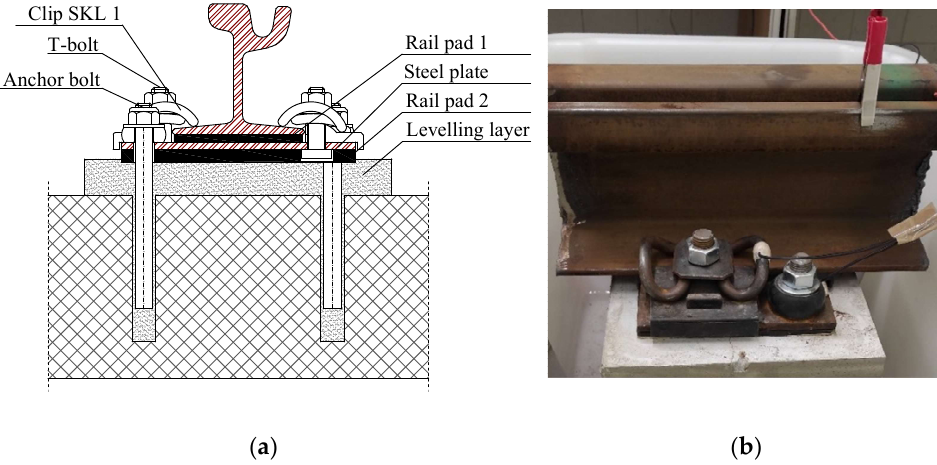
Figure 3. ( a ) Cross section of an indirect fastening system. ( b ) Real-scale sample of the indirect fastening system used in the tram track infrastructure in Zagreb, Croatia.